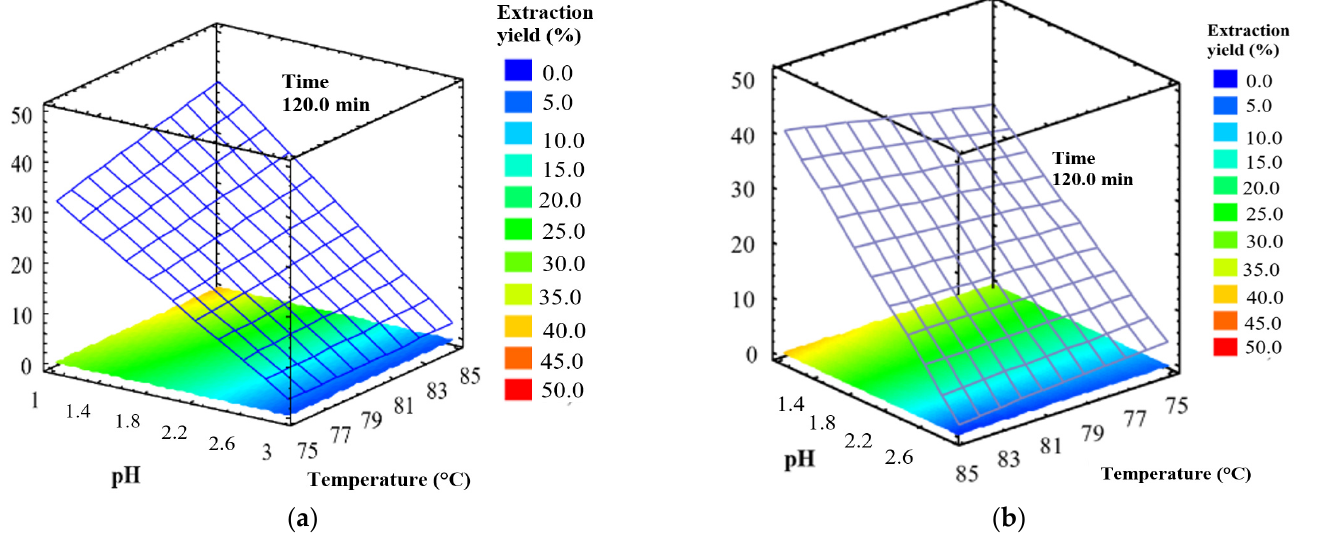
Figure 1. Response surface plots of pectin yield as a function of pH and temperature: ( a ) Tahiti lime ( b ) King mandarin.